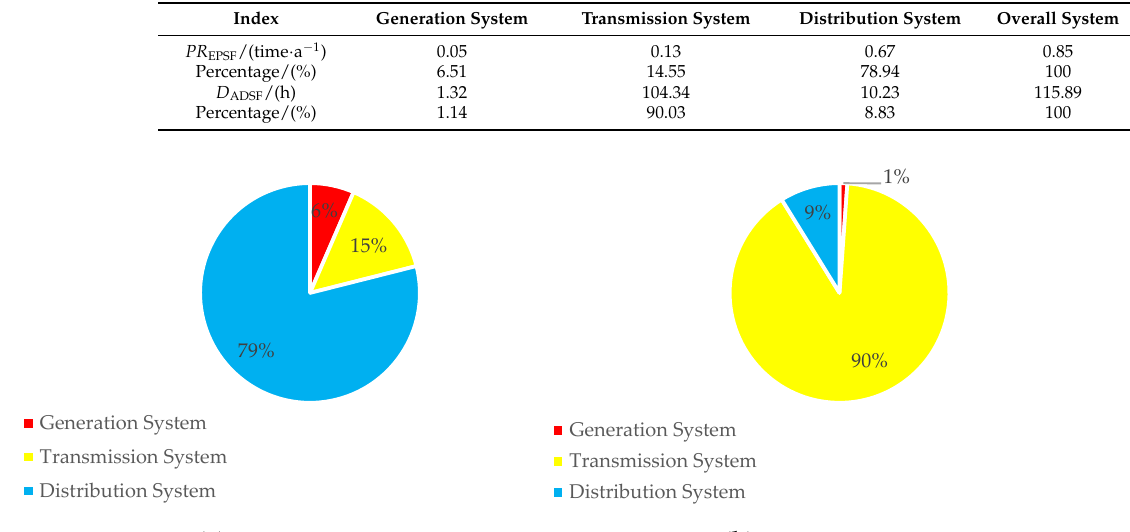
EPSF for subsystems; ( b ) percentage of P ADSF for